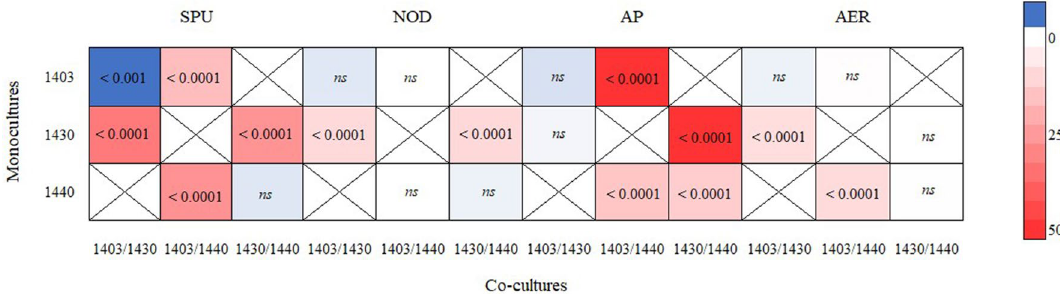
Figure 6. Results of post-hoc with Tukey’s honestly significant difference (HSD) on the effect of treatment on each NRP class concentration; see Supplementary Table 6 for details. The cell-plot colors represent the mean difference between the mono- and co-cultures, with blue showing higher values in monoculture and red in co-culture. NRP classes are: SPU, spumigins; NOD, nodularins; AER, aeruginosins and AP, anabaenopeptins. The p -value of the test result indicated in each cell; ns non-significant.